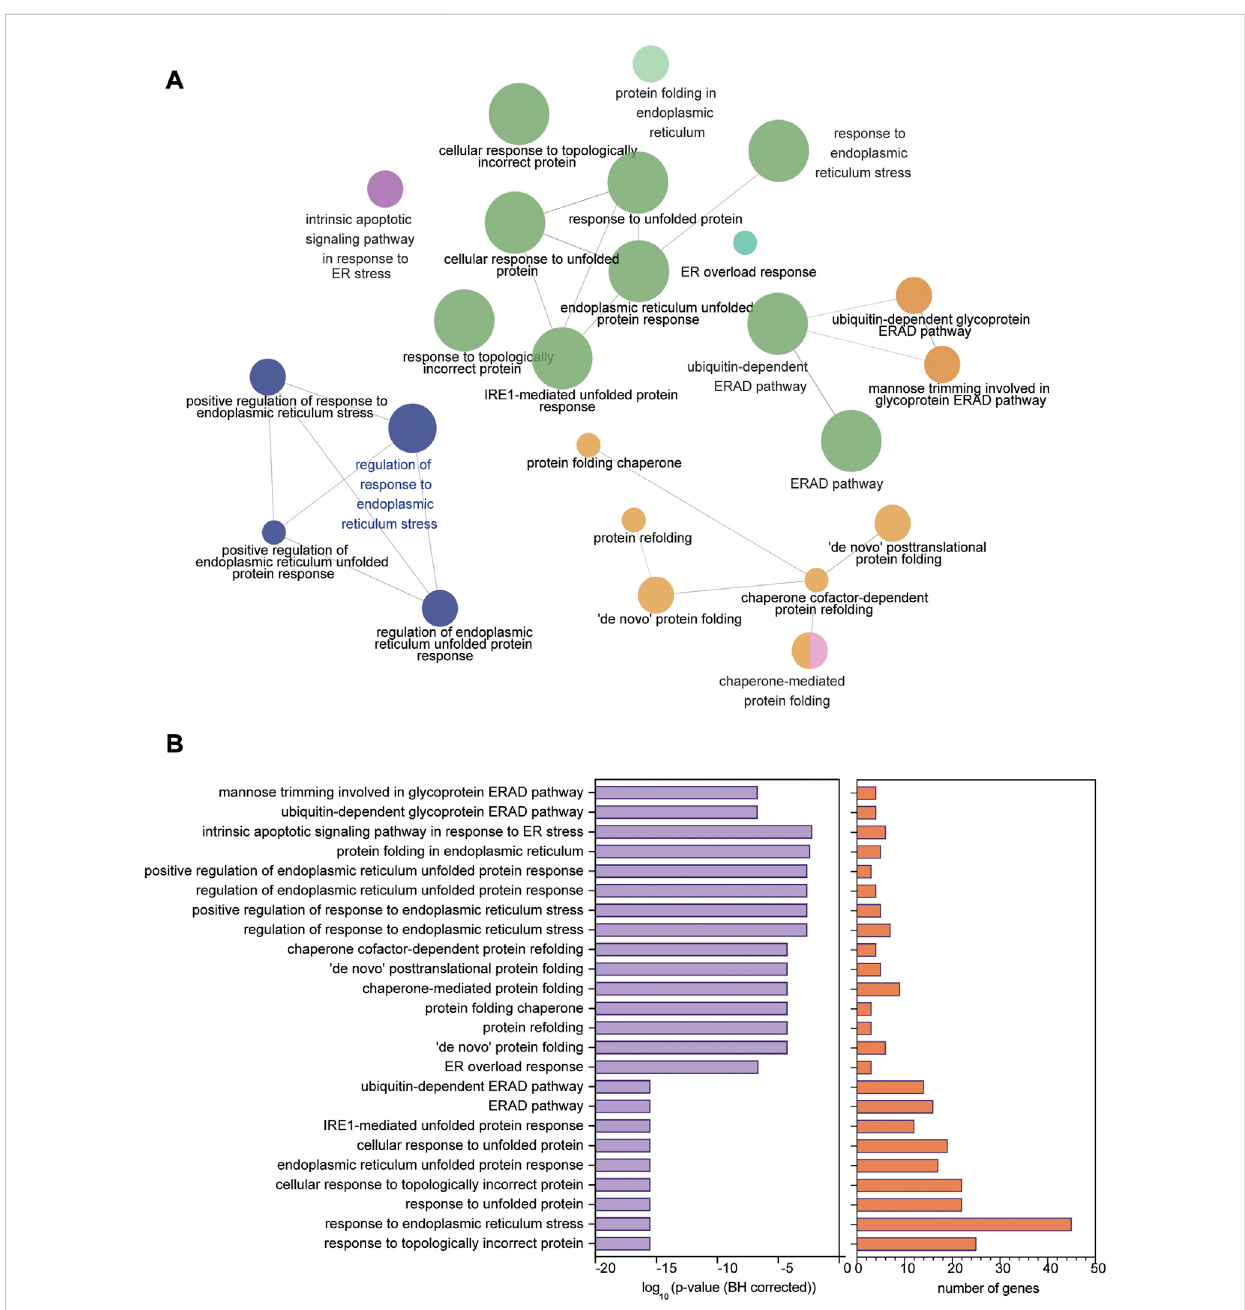
ERstressandUPR-relatedprocessesidenti fi edinhumandystrophicmuscle. (A) OntologyprocessesrelatedtoERstressandtheUPRanalyzedusing ClueGO in upregulated genes from the human Affymetrix data chip analysis mapped in Cytoscape. (B) p -value (BH corrected) and number of genes in each of the 24 processes identi fi ed. Signi fi cance of enrichment established at FDR < 0.01 (BH